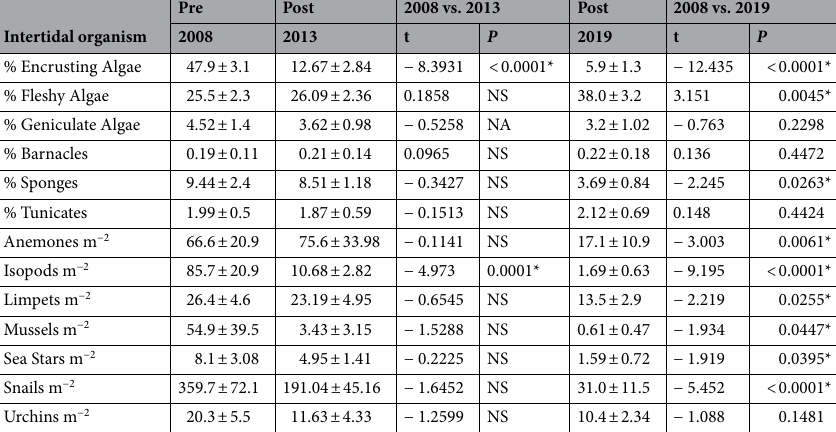
Table 1. The relative abundance of intertidal organisms measured before and after rat eradication (Mean ± SE) (2008 and 2013: n = 8; 2019: n = 7). * P is significant with α < 0.05.